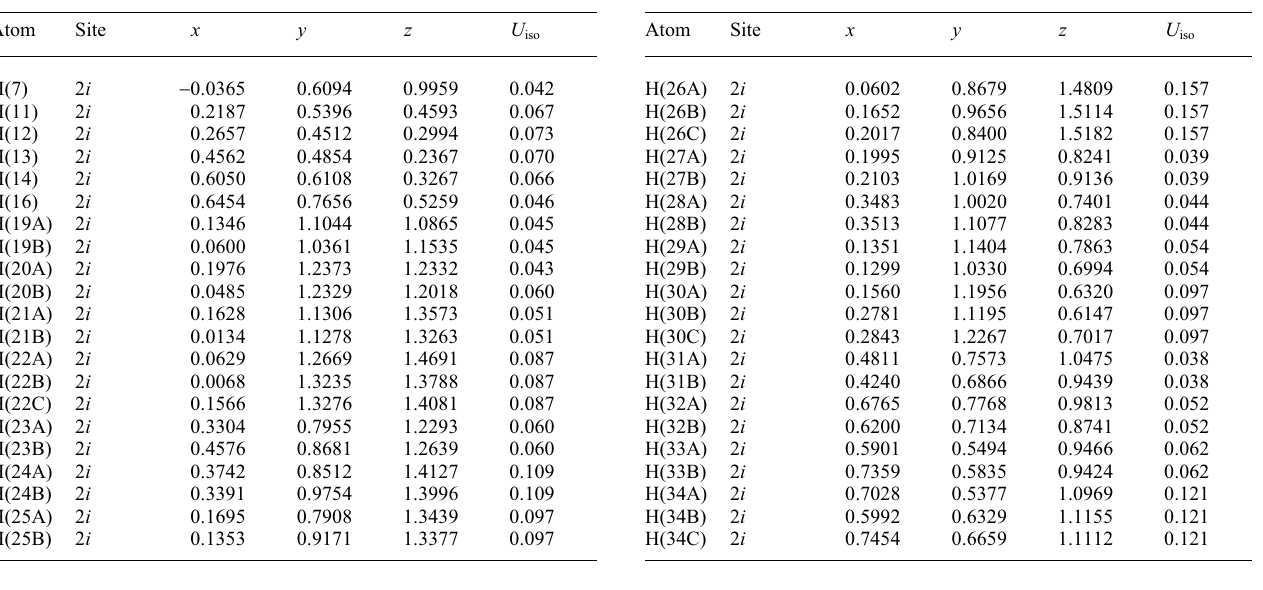
Table 3. Atomic coordinates and displacement parameters (in Å 2 ).